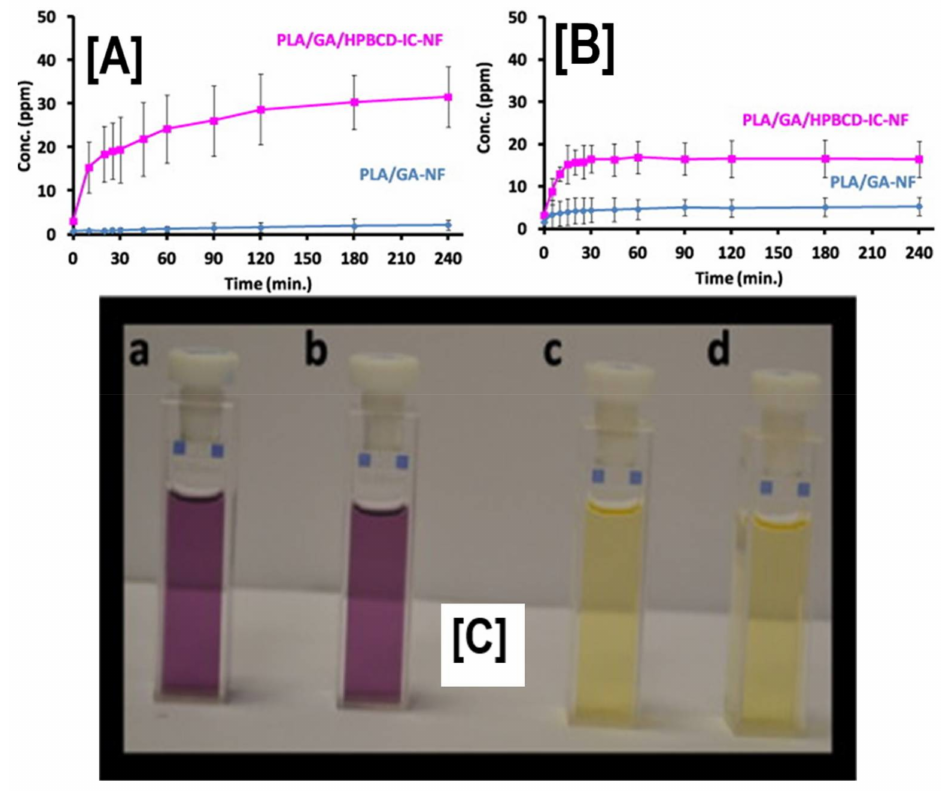
Figure 13. Total cumulative release and antioxidant characteristics of gallic acid (GA) released from PLA/GA-HP- β -CD nanofibers. The total cumulative release of GA from PLA/GA-HP- β -CD nanofibers was always higher in water ( A ) and 10% ethanol solutions ( B ), than those released from PLA/GA nanofibers, owing to the enhanced dissolution characteristics of GA/HP- β -CD compared to free GA. In addition, the DPPH assay showed that the presence of GA in both PLA/GA, as well as PLA/GA-HP- β -CD nanofibers, retained its antioxidant characteristics ( C ). Images adapted and reproduced with permission from [114]. Copyright Elsevier Ltd.,